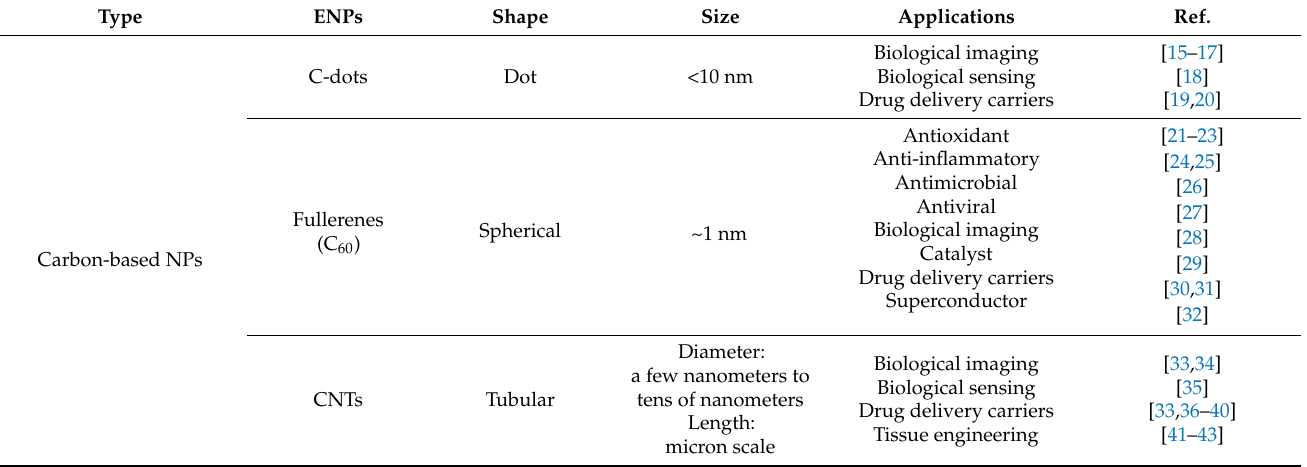
Table 1. Type, shape, size, and main applications of